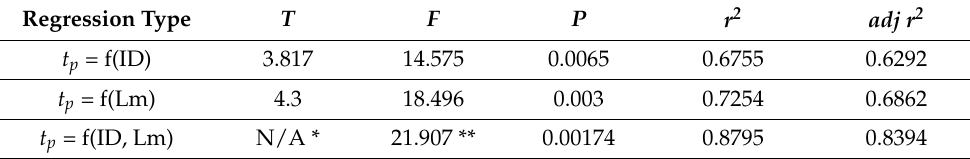
Table 3. Comparison of test parameters for regression and multiple regression. Regression